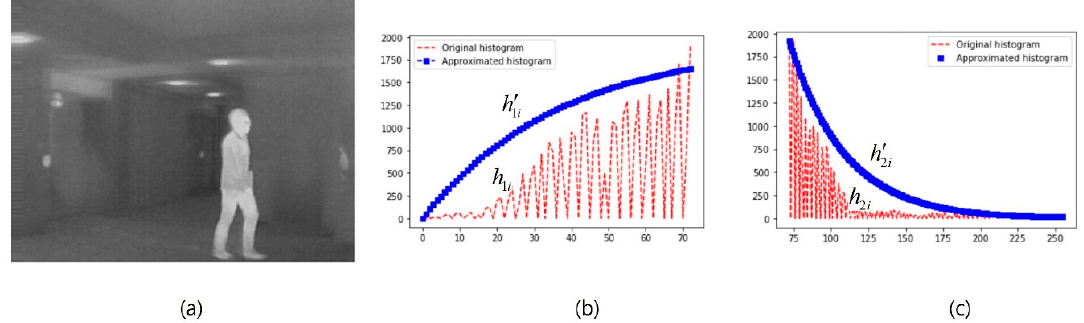
Figure 2. ( a ) Original image; ( b ) the approximated part and original part for the first part of the original histogram; and ( c ) the approximated part and original part for the second part of the original